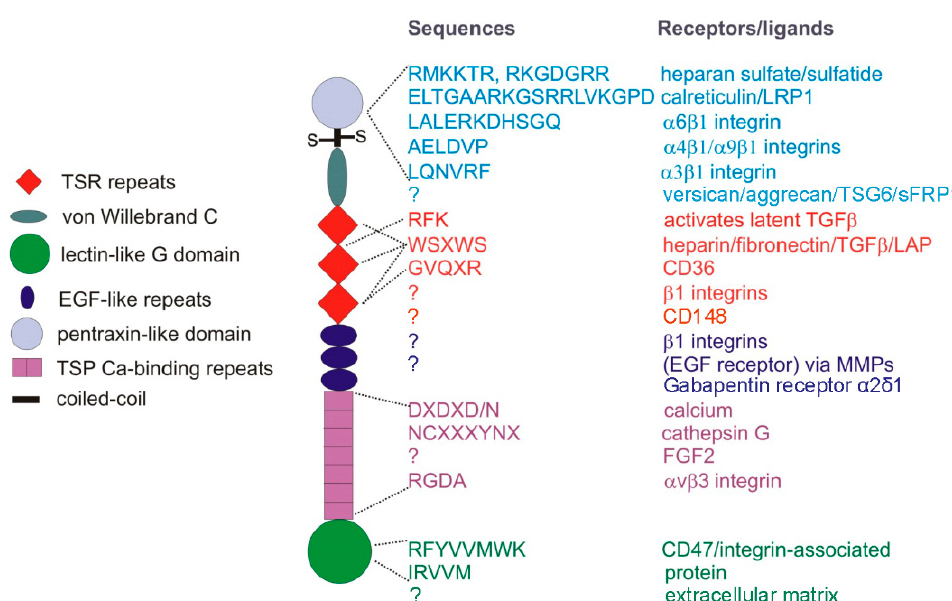
Figure 1. TSP1 subunit domains and their cell surface receptors or extracellular ligands. TSP1 is a ~450 kDa homotrimer of subunits linked by disulfide bonds near the N-terminal pentraxin-like domain. Type 1 TSP1 repeats (TSR), EGF-like, and calcium-binding repeats form the central stalk region of TSP1, connecting the N- and C-terminal globular domains.